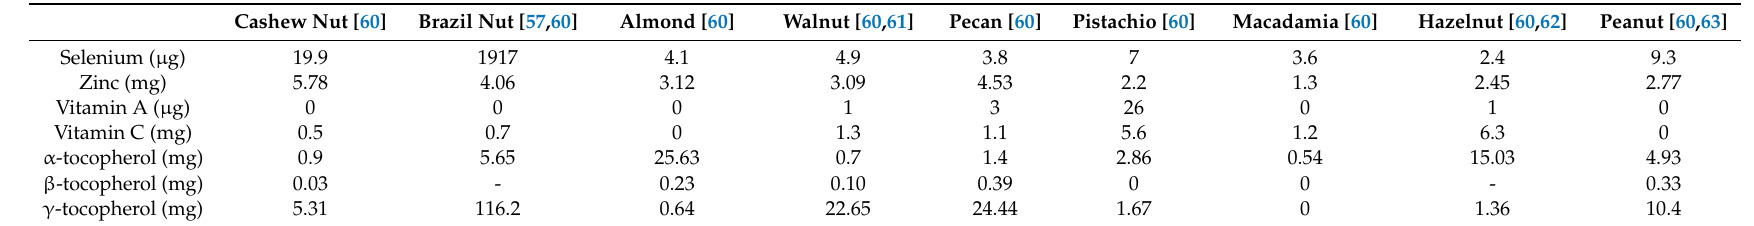
Table 3. Nutrient antioxidant concentration of di ff erent nuts and seeds per